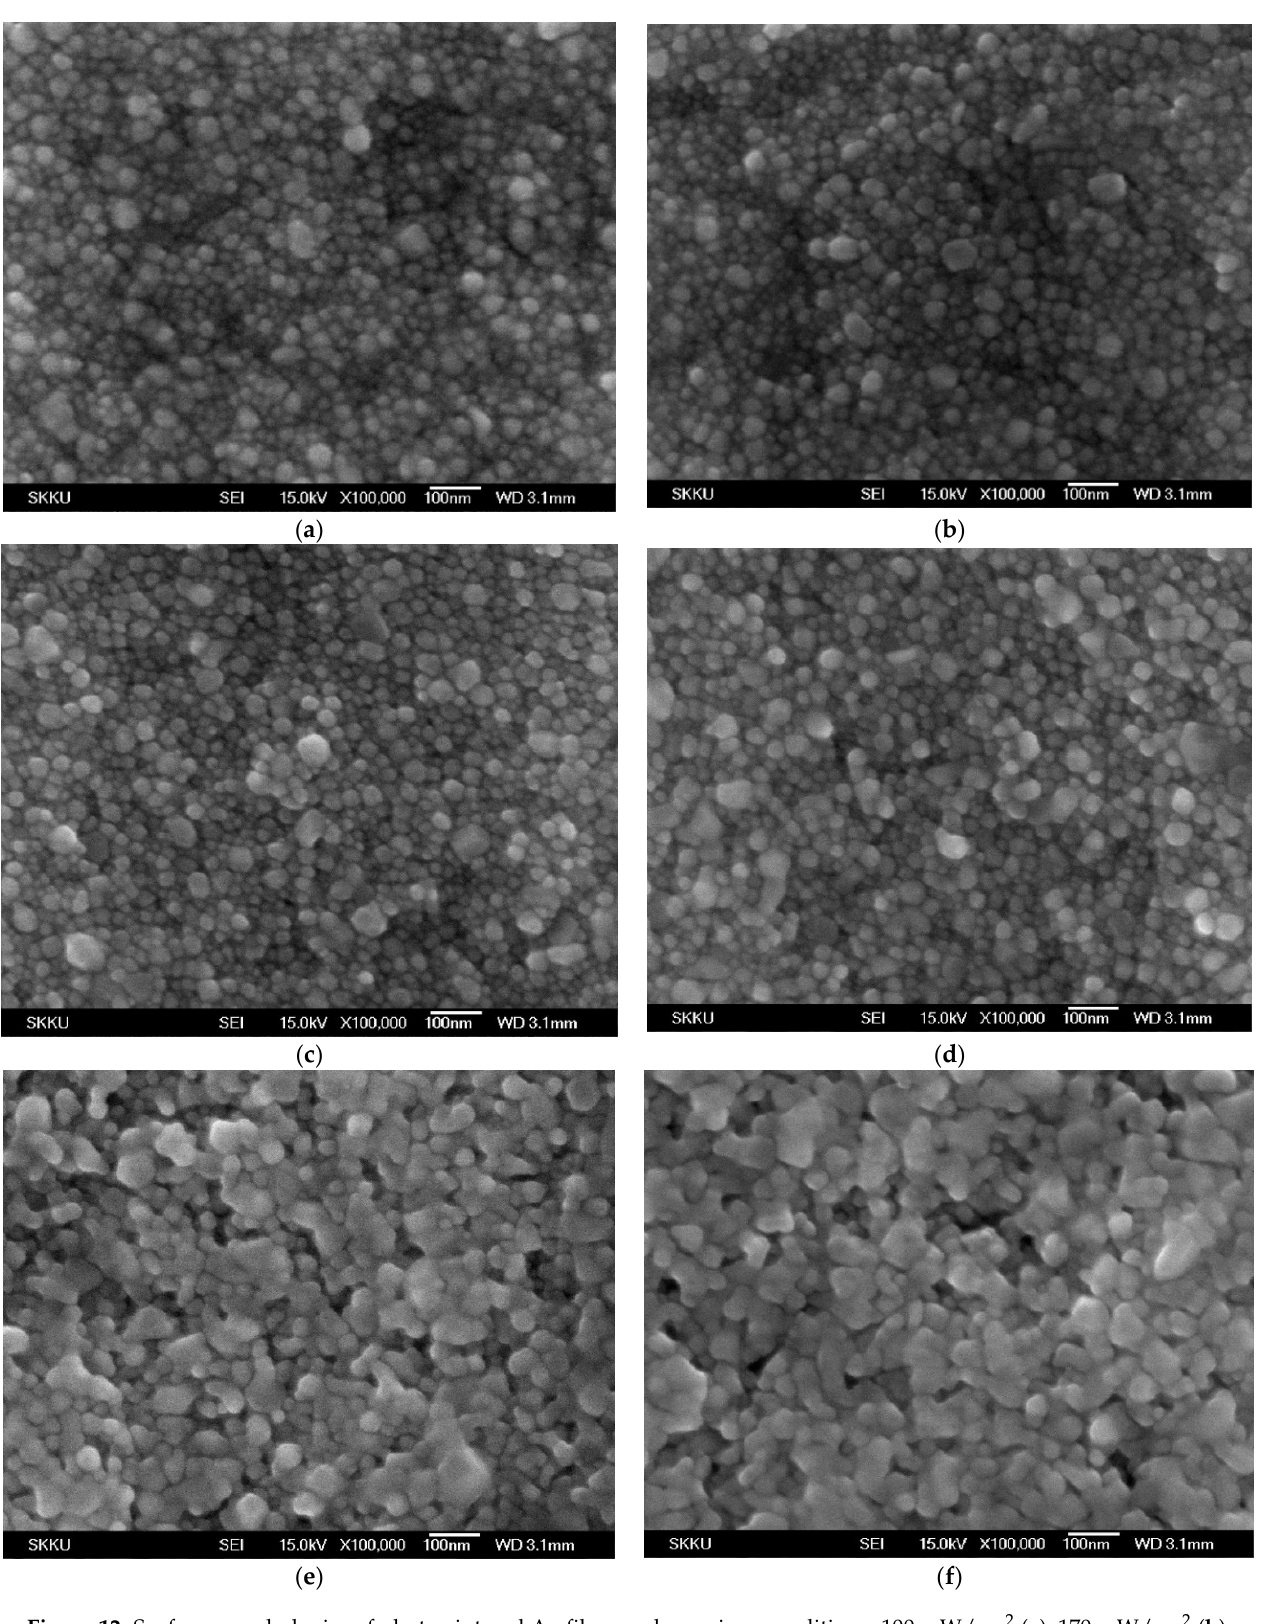
Figure 12. Surface morphologies of photo-sintered Ag films under various conditions: 100 mW/cm 2 ( a ), 170 mW/cm 2 ( b ), 230 mW/cm 2 ( c ), 300 mW/cm 2 ( d ) for 10 min, respectively. The sample ( e , f ) were photo-sintered at 300 mW/cm 2 for 30 min and 50 min. The wavelength of UV-LED module was 365 nm.